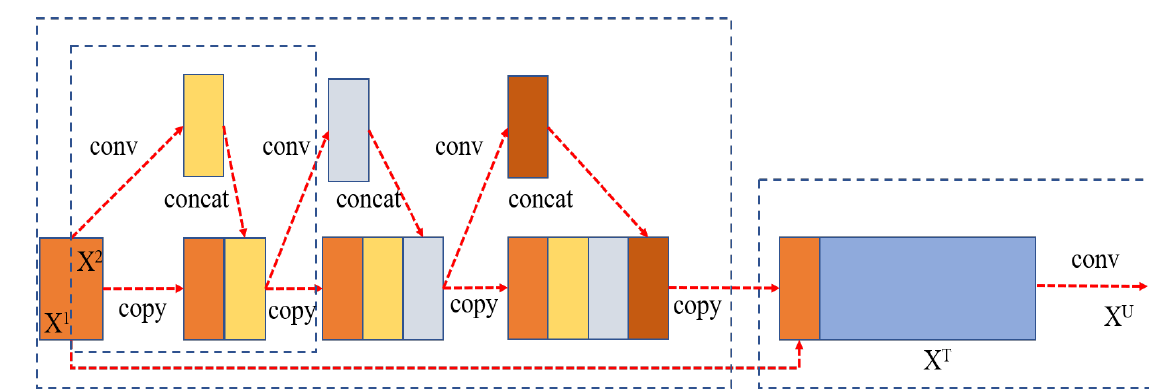
Figure 2. CSP network structure.